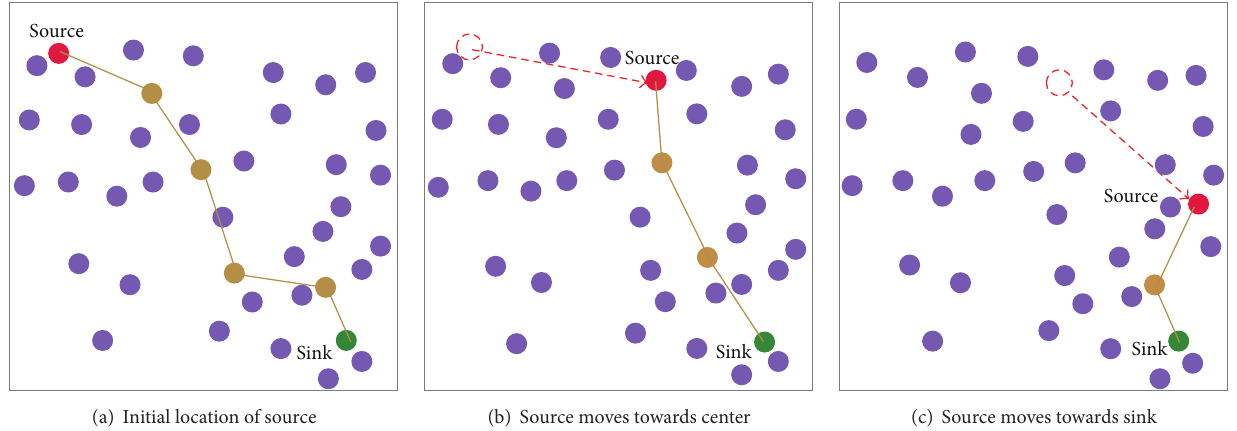
Figure 5: Source node mobility scenario, change in topology and routing